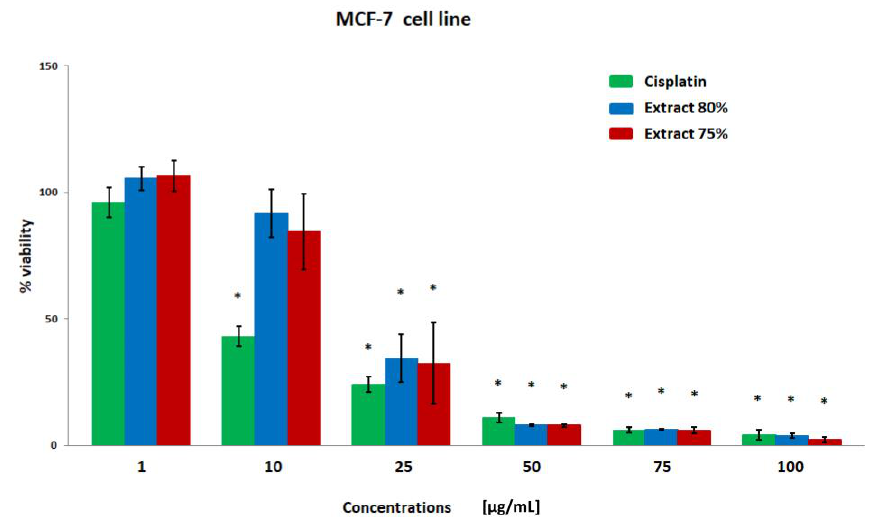
Figure 3. The viability of the MCF-7 cell line (%) after 24 h incubation with various concentrations of cisplatin, extract 80%, and extract 75% measured with MTT test. Significant values (*) compared with Cisplatin with p < 0.05 (one-way ANOVA with Tukey’s post hoc test).